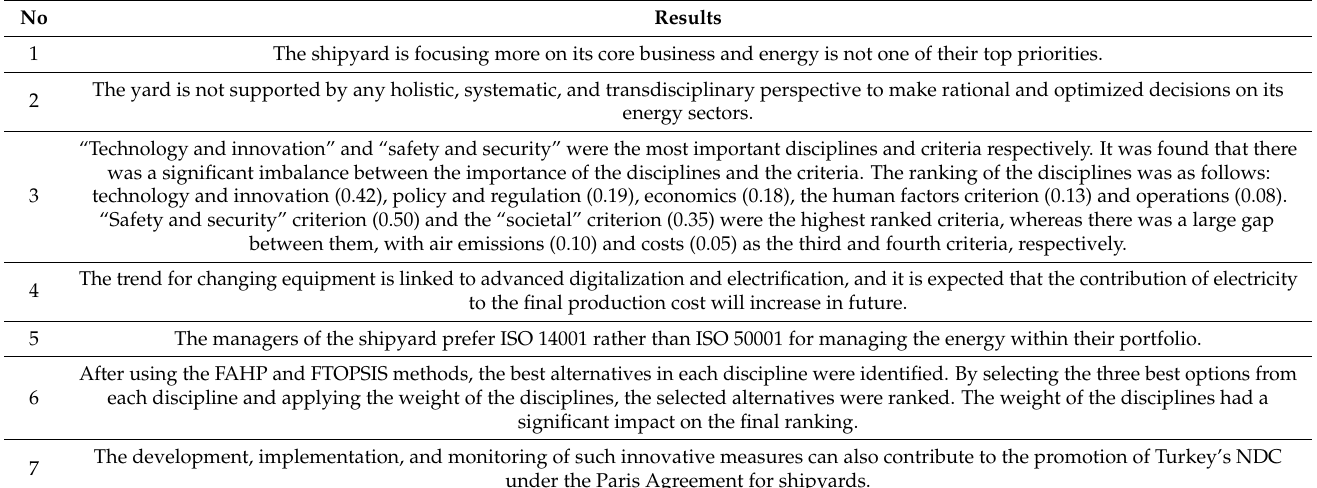
Table 10. The results of the implementation of the framework for the case of the studied shipyard. No